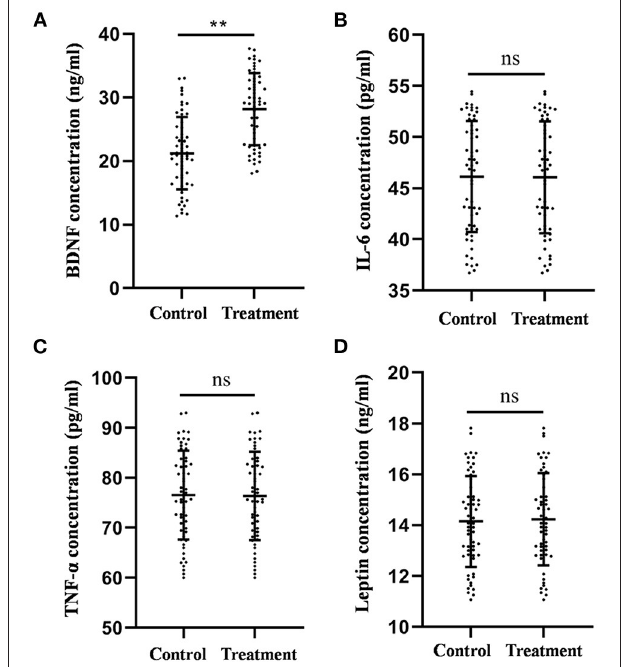
FIGURE 2 | Comparison of the plasma BDNF (A) , IL-6 (B) , TNF- α (C) , and leptin (D) levels between the treatment group and the control group after 4-week treatment. ** P < 0.01, was considered statistically